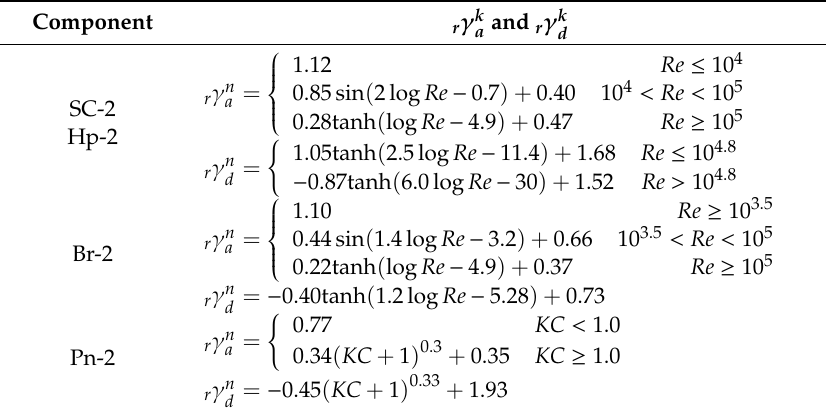
Table 2. List of correction factors for each